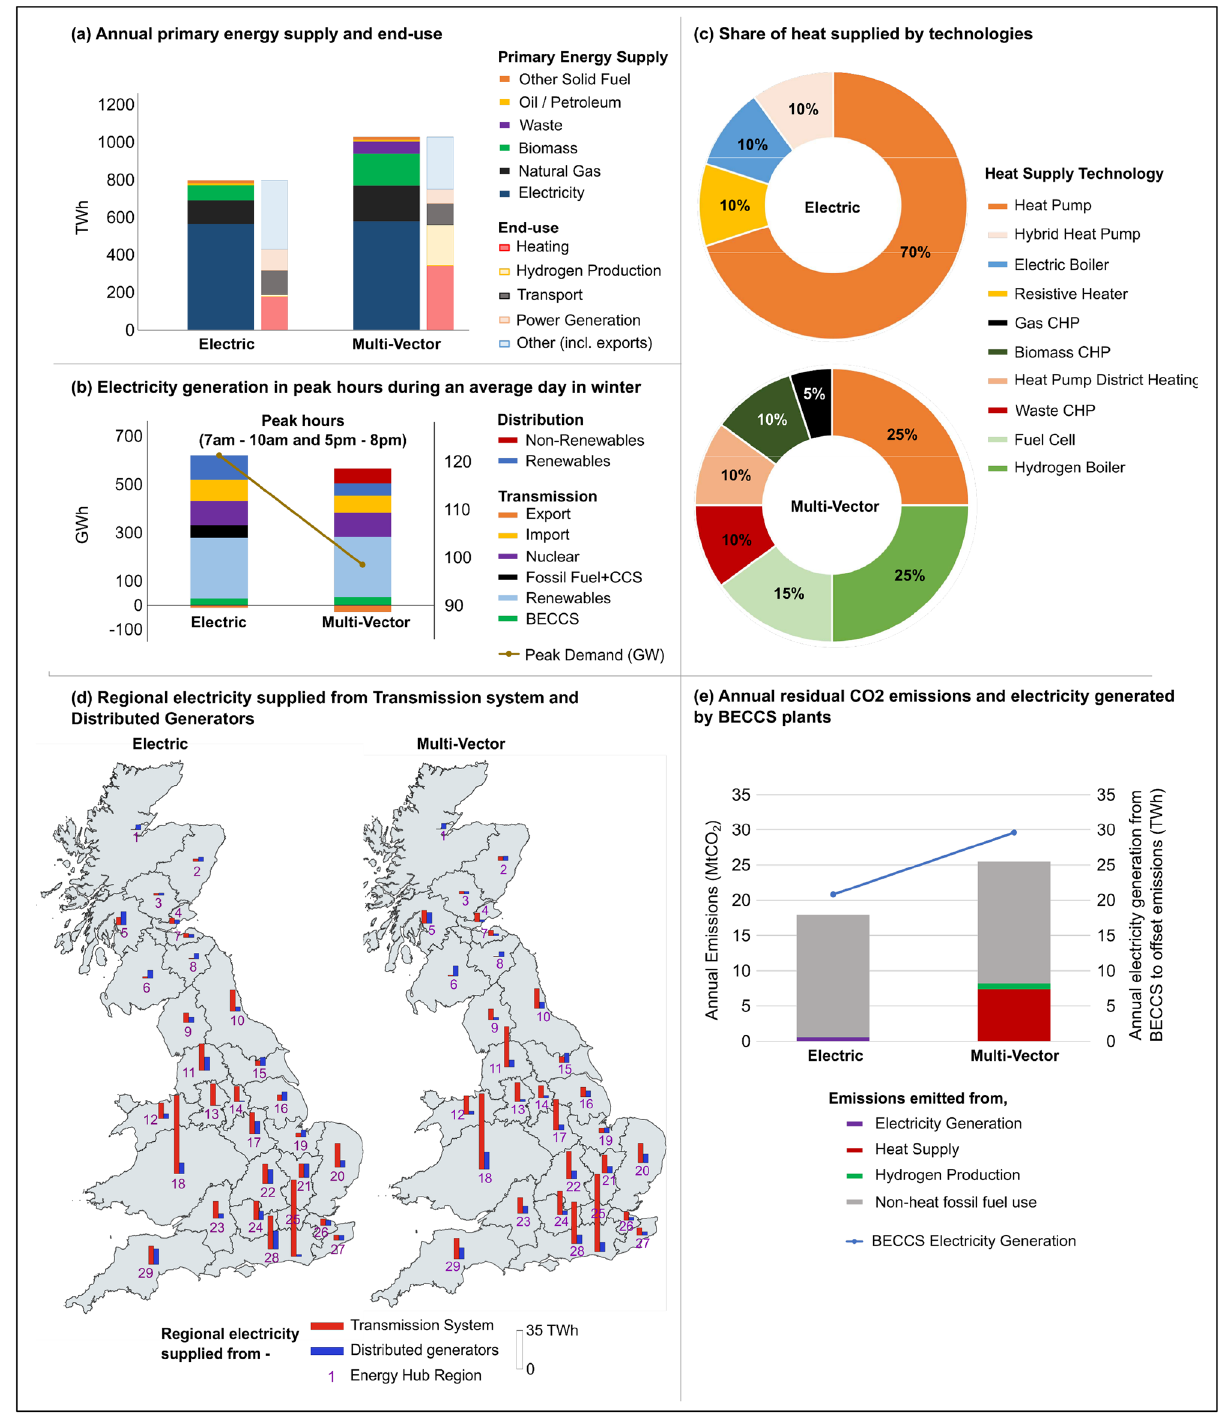
Figure 4. Comparison of different future energy supply strategies (Multi-vector and Electric) assuming centralised system operation. ( a ) Annual primary energy supply and consumption by end-use, ( b ) electricity generation in peak hours during a typical day in winter, ( c ) share of heat supplied by technology, ( d ) regional electricity supply split between the transmission system and distributed generators to meet local electricity demands ( e ) annual residual CO 2 emissions, and electricity generated from Bioenergy with Carbon Capture and Storage (BECCS) plant for the Energy Supply Strategies in the year